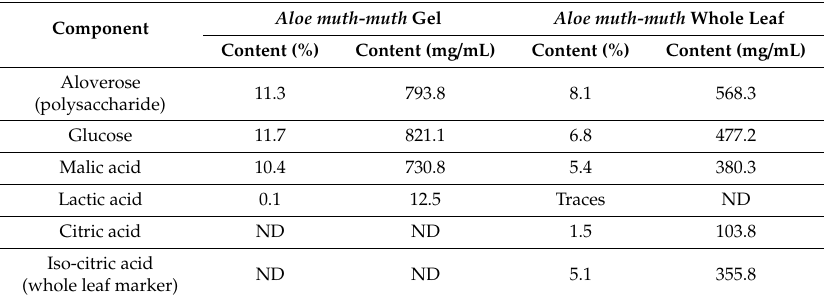
Key to abbreviations: ND—not